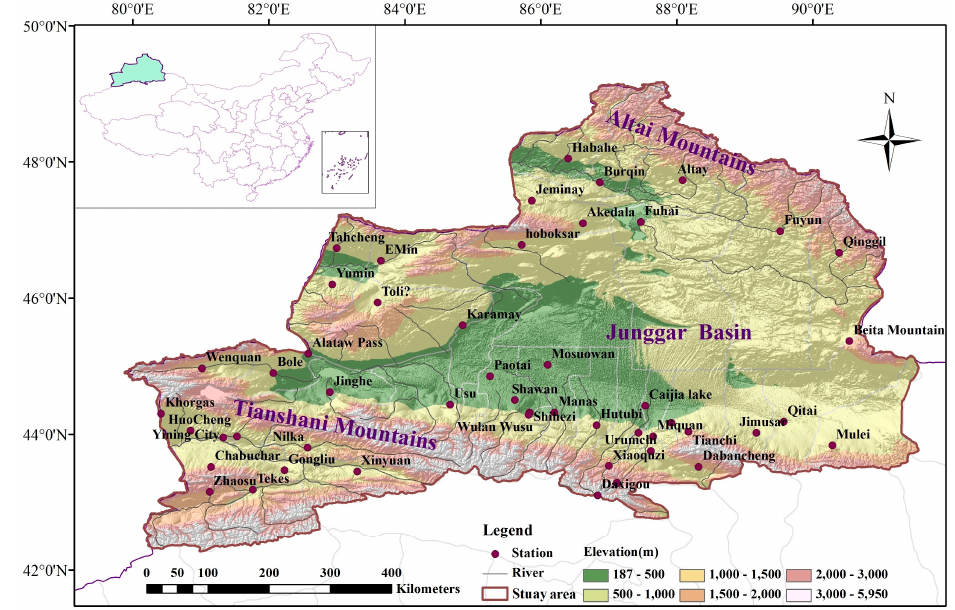
Figure 1. Topographic relief and the location of meteorological observation stations in Northern Xinjiang, Northwest China.